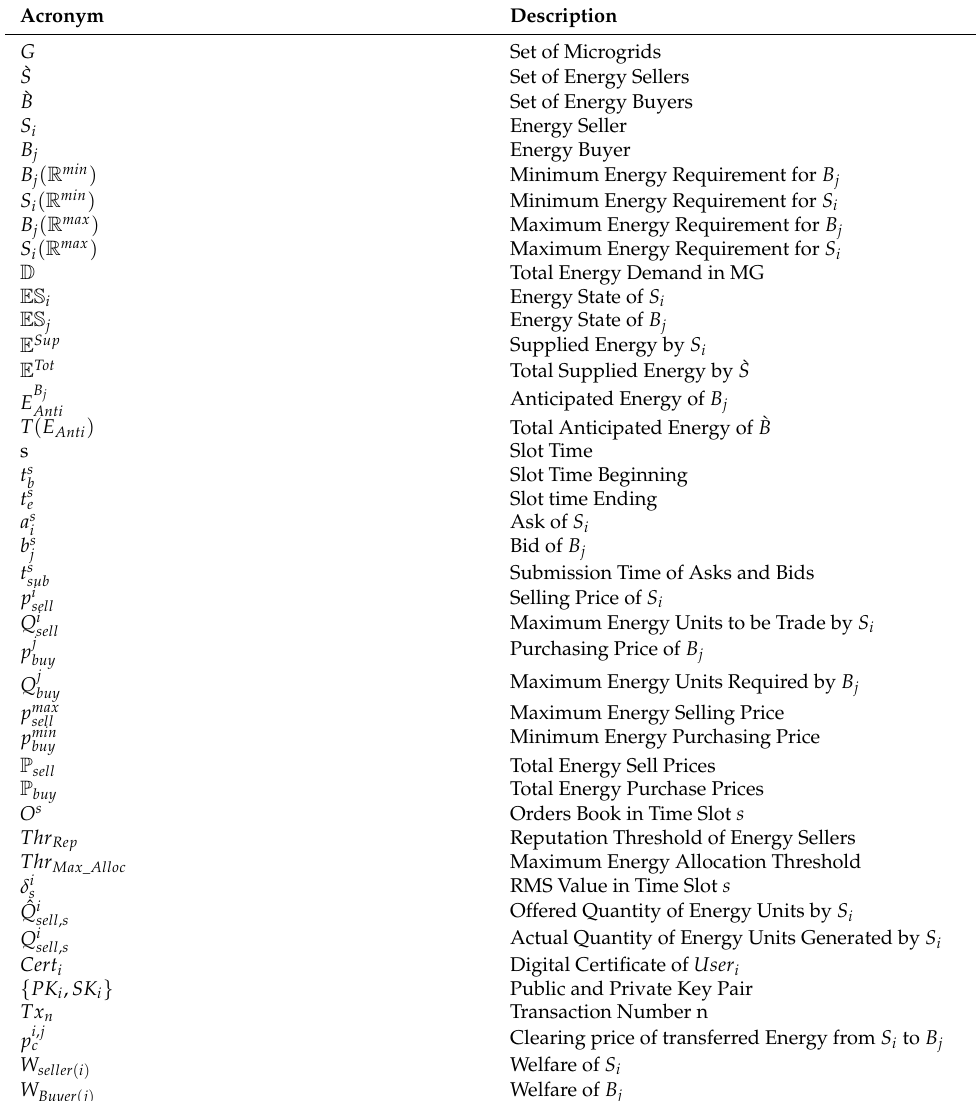
Tables A1 and A2 summarize the notations and acronyms used in our work. Table A1. Notations used in this